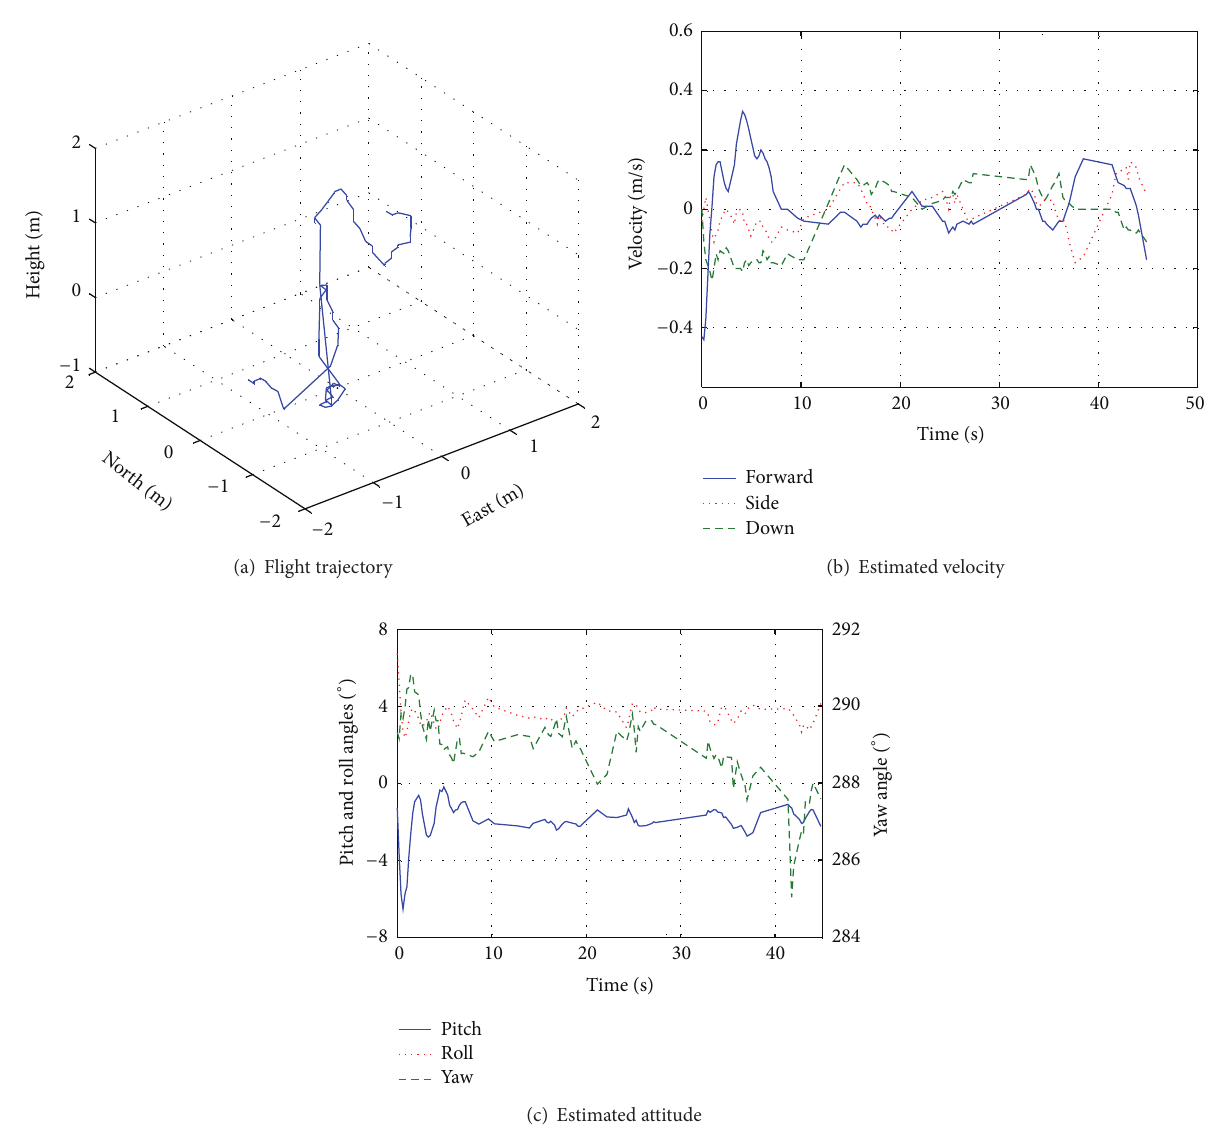
Figure 12: Estimated flight states of miniature unmanned helicopter in hovering